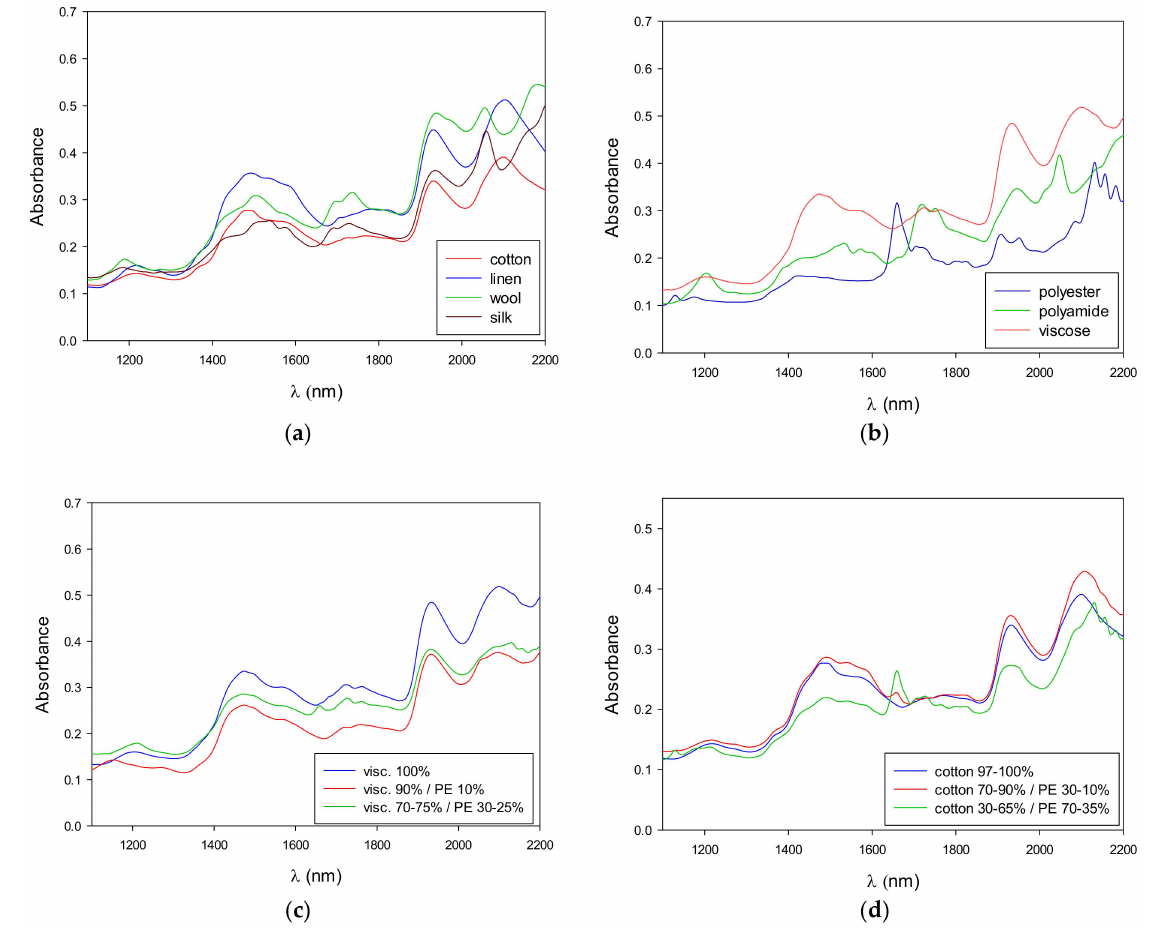
Figure 2. ( a ) Natural fibers. ( b ) Manmade fibers. ( c ) NIR spectra of binary mixtures (viscose/PE). ( d ) NIR spectra of binary mixtures